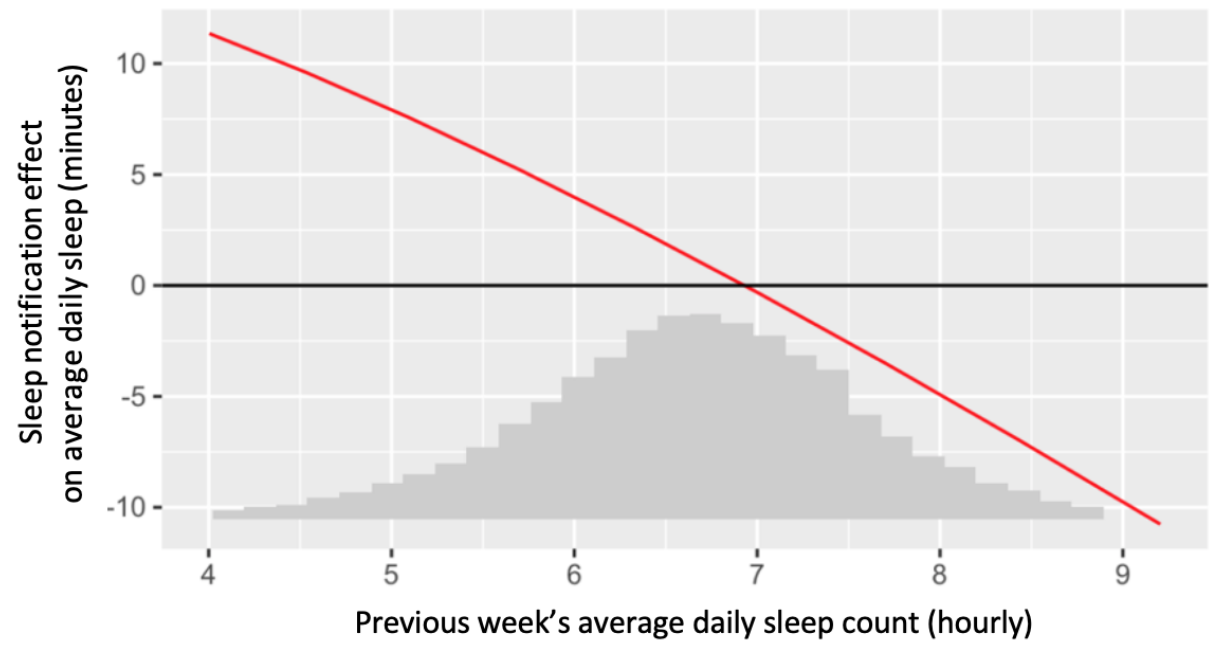
Figure 7. Estimated treatment effects (compared with no notifications) of sleep notifications on average daily sleep minutes, at various values of previous week’s hourly sleep. The x-axis also contains a scaled histogram of previous week’s average daily sleep